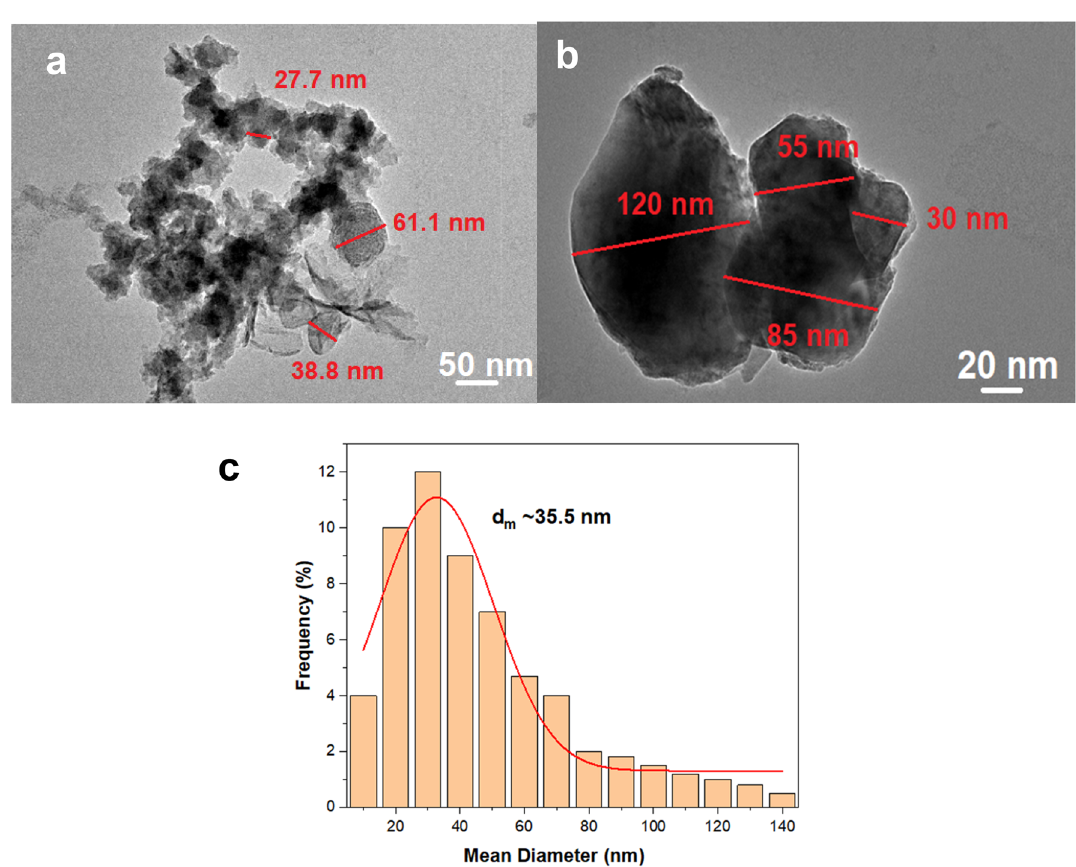
Figure 4. TEM micrographs ( a,b ) and respective histogram ( c ) of the Cu-based oxide nanostructures prepared at 80 °C. The fitting is based on the Gaussian fitting distribution and the d m ∼ 35.5 that the stacking of the flakes is due to the natural chemical adhesions caused by the quinone 71 , which is respon- sible for the hydrophobic terminated layer surfaces in all the samples. Hydrophobic surface promotes cohesion between the nanostructures 72–74 . This can be visibly proven by the less dispersion and easy sedimentation at the bottom part of the glass vial. The FESEM images of the as-produced Cu-based oxide nanostructures samples are depicted in Fig. 5. As seen in the images, aggregation occurs in all samples. The micrographs show that at 60 °C (Fig. 5a), the sample